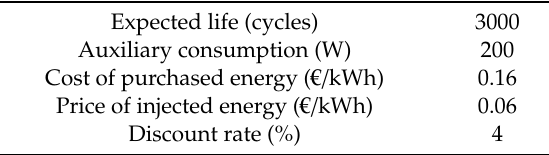
Table 6. BESS equivalent cycles and corresponding expected life.